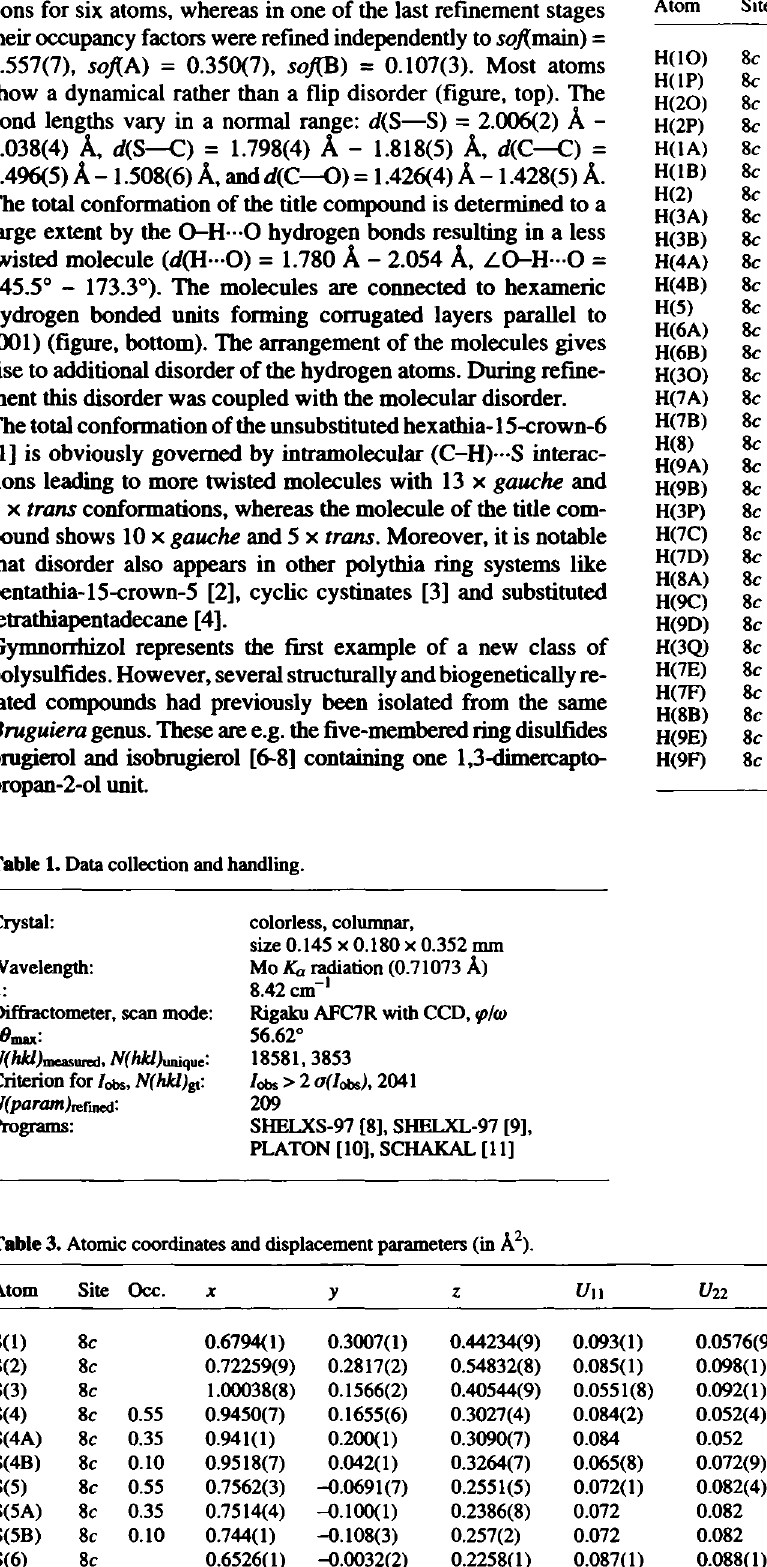
Table 3. Atomic coordinates and displacement parameters (in À 2